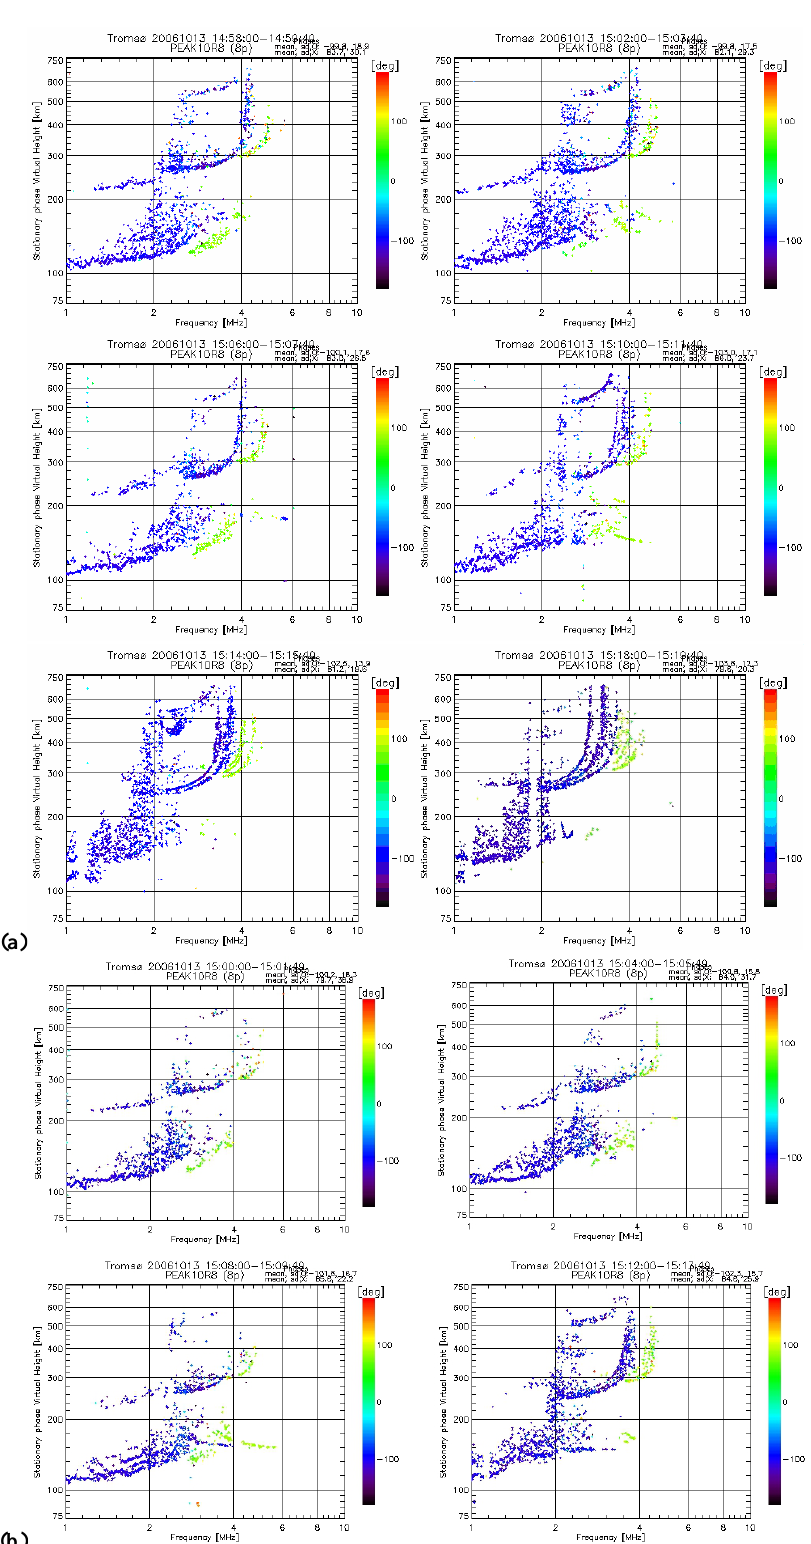
Fig. 2. Ionograms obtained by the dynasonde at Tromsø in the course of the EISCAT/HEATING experiment on 13 October 2006: (a) iono- grams taken during heater-off periods; (b) ionograms taken during heater-on